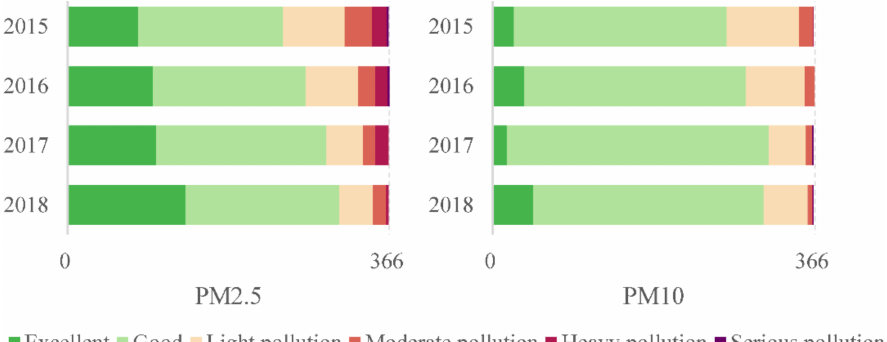
Figure 3. Daily count of daily average PM concentration in different grades from 2015 to 2018. The daily average particle concentrations in the BTH region were calculated from 2015 to 2018. Red indicates a high concentration, and green and blue indicate a low